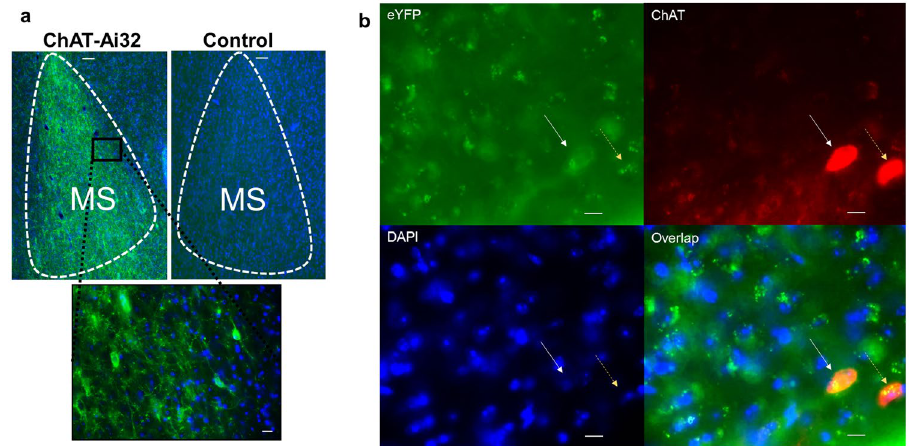
Figure 1. ChAT-Ai32 mice expressed eYFP in a subset of cells in MS, as well as in other forebrain regions. No fluorescence was visible in littermate controls negative for Cre. ( a ) Slices (40 μ m) were taken from ChAT-Ai32 mice and littermate controls negative for Cre and imaged using light microscopy (scale bars top 50 μ m, bottom 10 μ m). Nuclei are stained with DAPI. ( b ) A subset of slices were immunostained for ChAT to demonstrate co- localization with native eYFP in ChAT-Ai32 mice (white arrow eYFP + , yellow arrow eYFP − , scale bars 10 μ